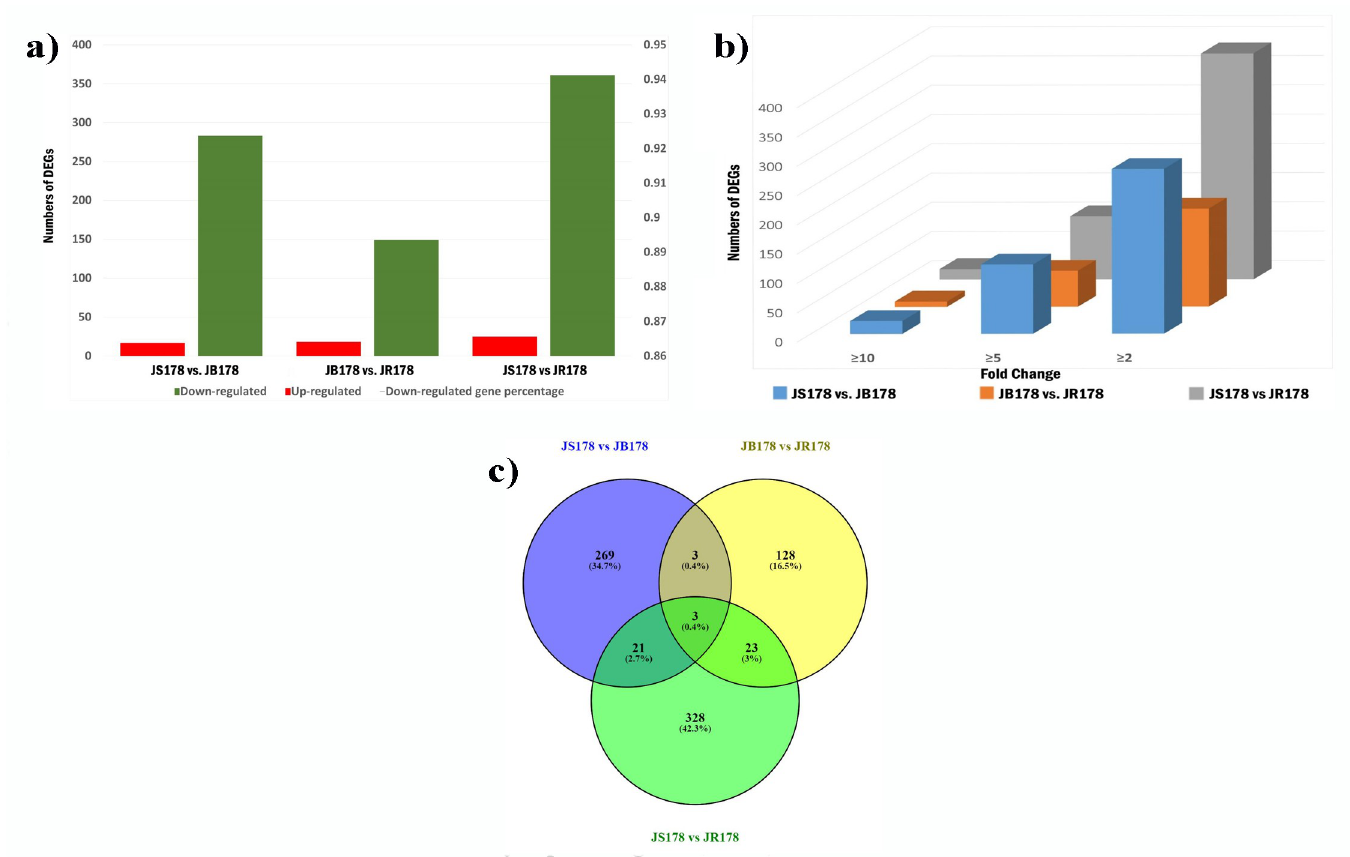
Fig 5. a) The number of differentially expressed genes (DEGs) between three different lines of cotton. The green color represented up-regulated, the red color represented down-regulated gene numbers on the X-axis, Y-axis represented the number of deferentially expressed genes. b) The fold change wise distributed numbers of genes under the comparison of three different lines. c) Venn diagram showing the distribution of unique and common DEGs among three comparisons